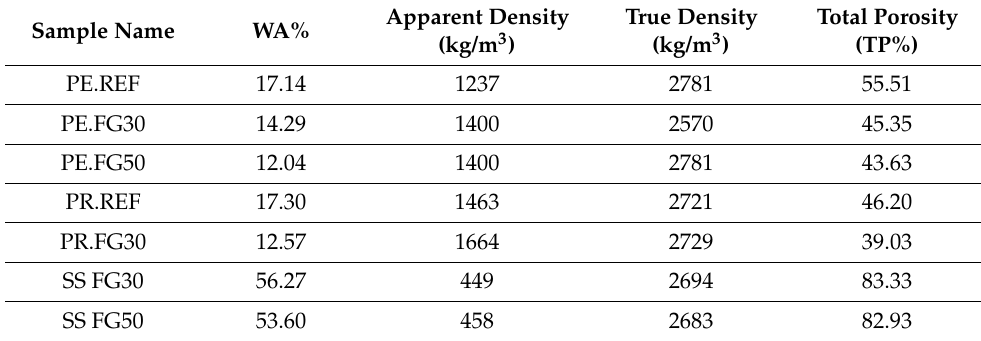
Table 2. Physical properties of the silica porous materials obtained by the different techniques.